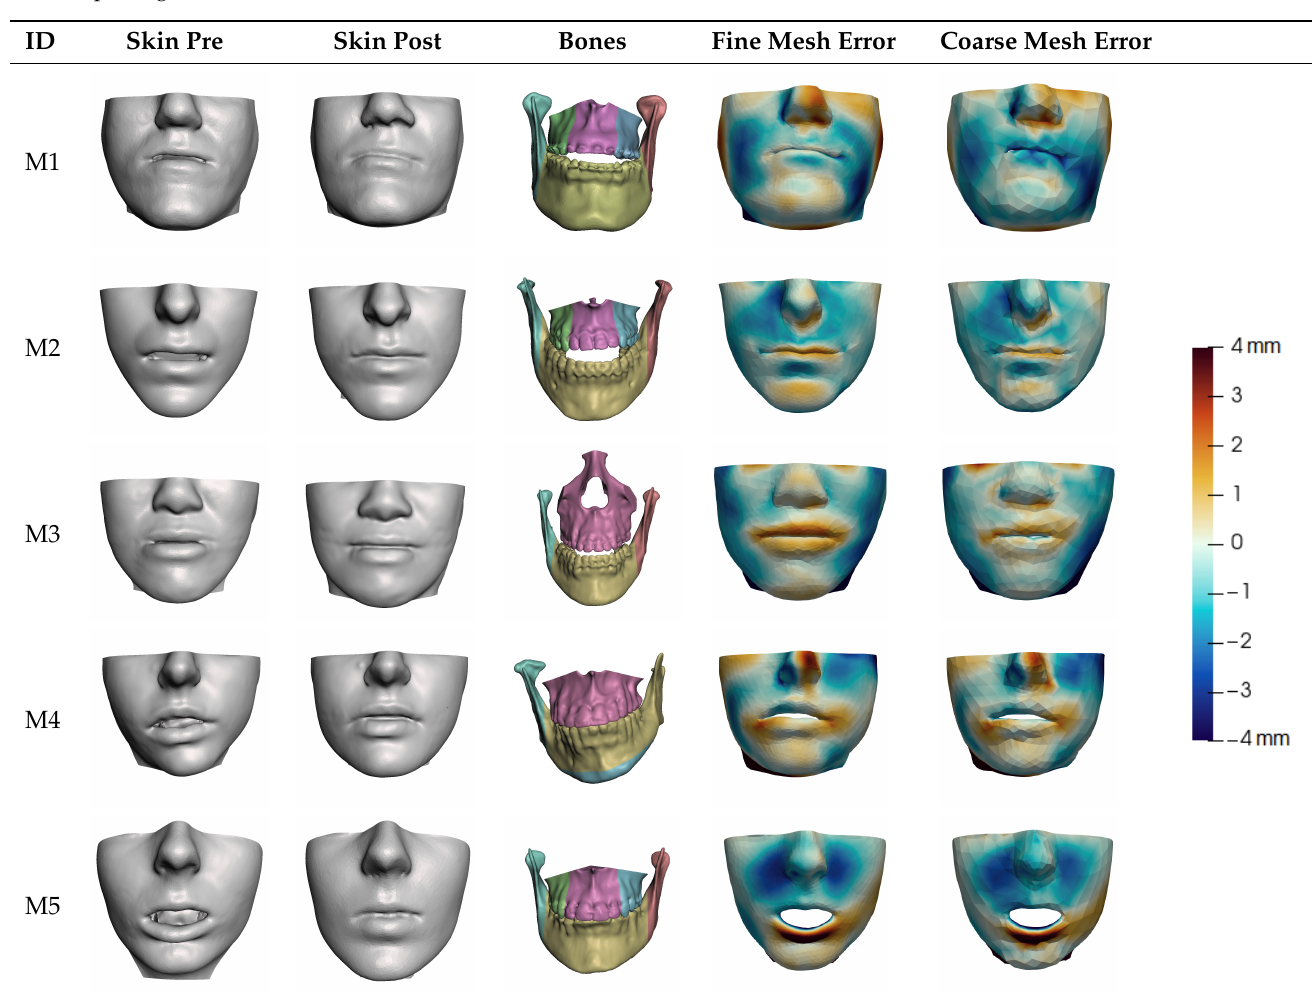
Table 2. Simulation results for patients M1 to M5. From left to right: pre-operative scan, post-operative scan, bone fragments produced during surgery, simulation error using a fine mesh, and simulation error using a coarse mesh. Scale of the color maps ranges from − 4 mm to 4